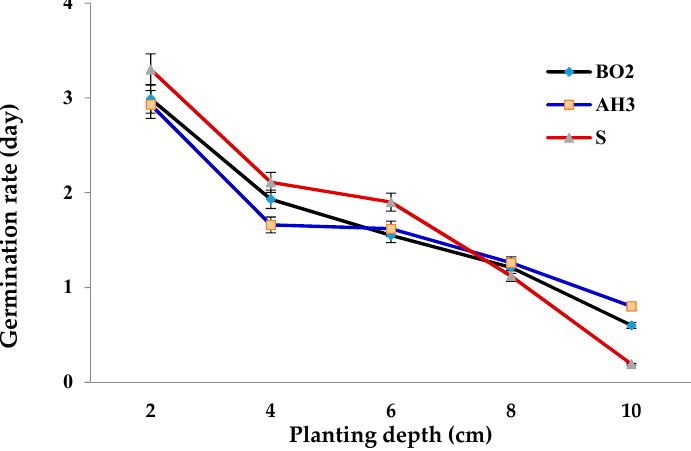
Figure 1. Effects of sowing depth on germination rate (GR) in HF (S) (red bars), BO2 (Ile-1781-Leu) (black bars), and AH3 (Ile-2041-Asn) (blue bars) Lolium rigidum populations. The corresponding equations are: Population S: y = 3.3371 + 0.2006 x , ( r 2 = 0.92); Population BO2 (Ile-1781-Leu): y = 2.7655 + 0.1520 x , ( r 2 = 0.91); Population AH3 (Ile-2041-Asn): y = 2.9417 + 0.1724 x , ( r 2 = 0.97).